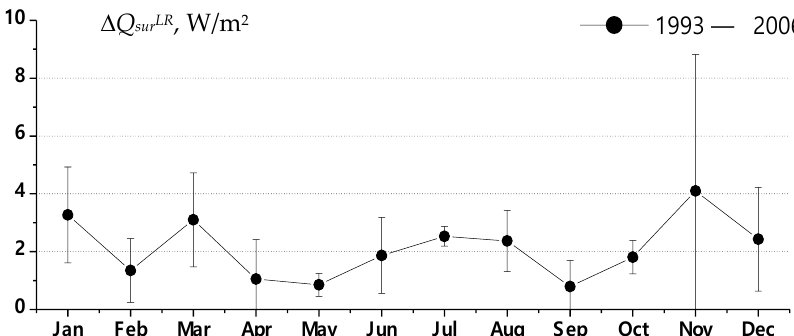
Figure 3. Dynamics of the difference between the fluxes of absorbed longwave radiation in the urban and rural areas.